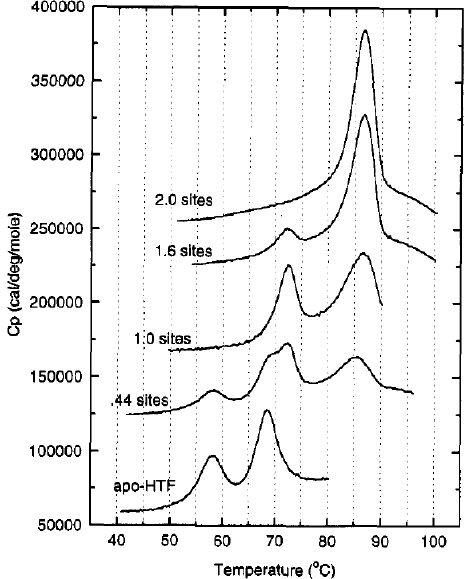
Figure 5. Differential scanning calorimetry (DSC) scans of 20 μ M sTf with different equivalents of Fe(III). Reprinted with permission from [18]. Copyright (1994) American Chemical Society.